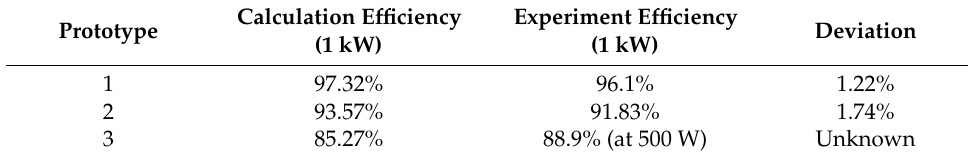
Table 4. Experiment and calculation